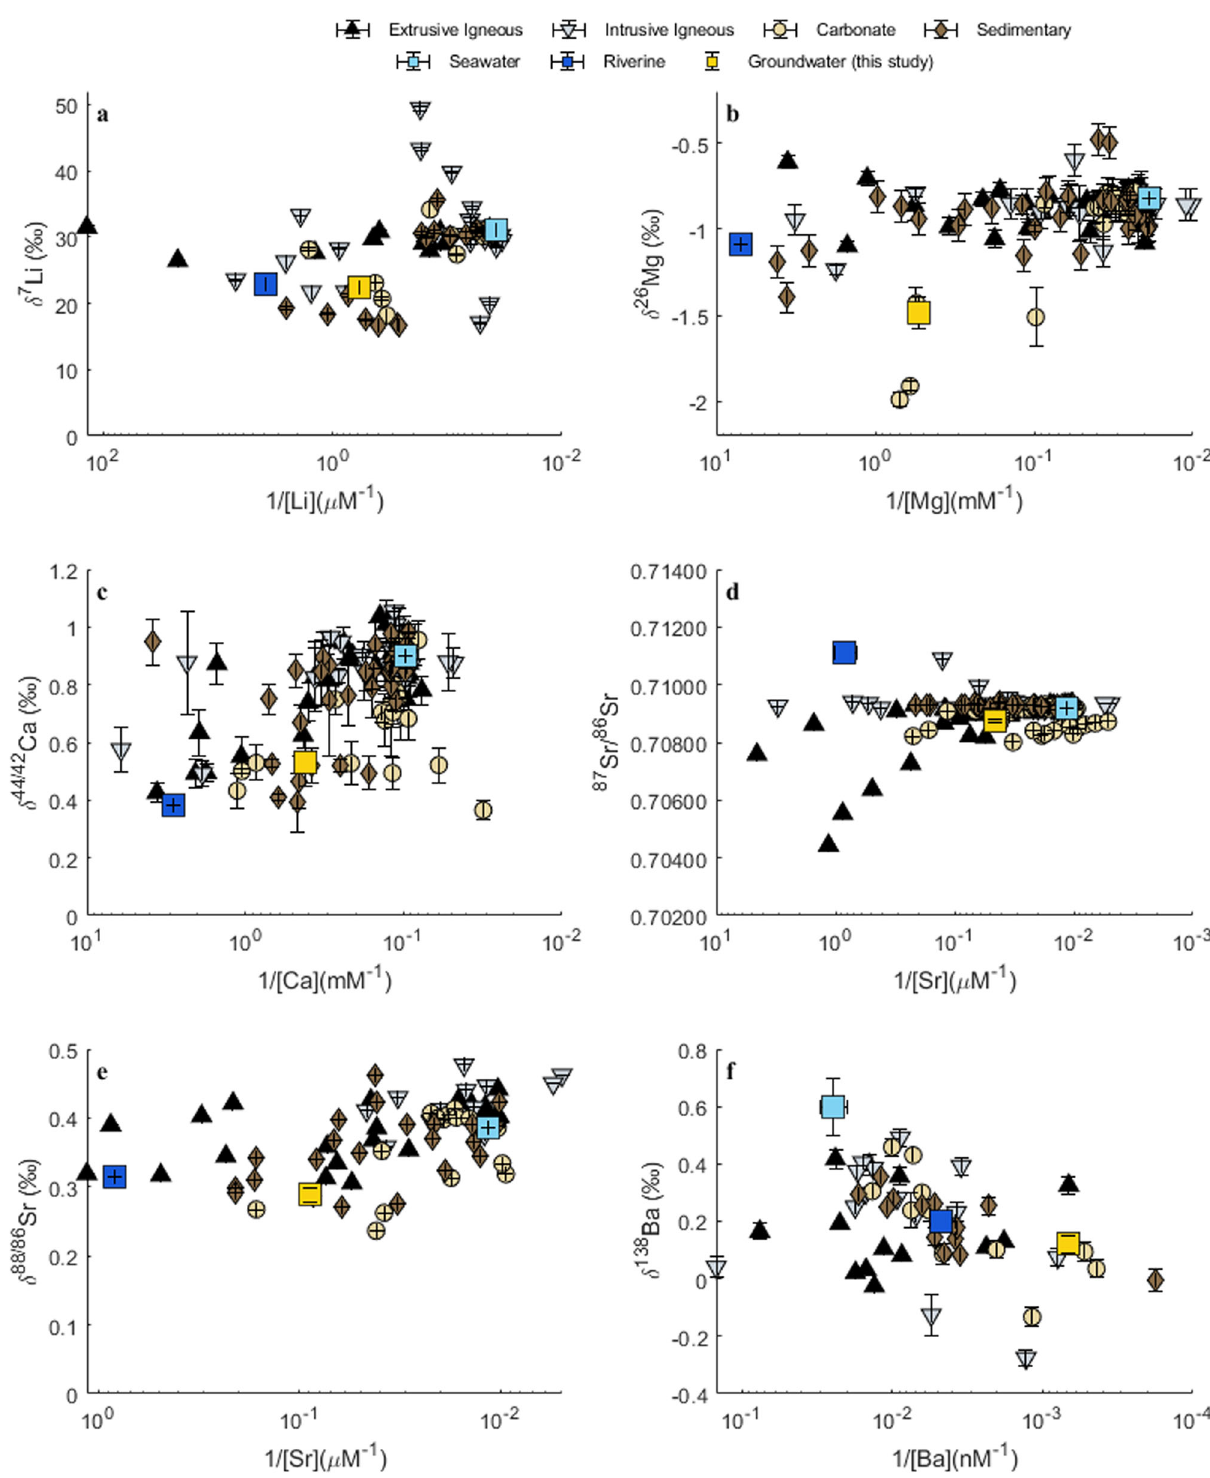
Fig. 3 Isotopic composition of samples. a – e Isotopic compositions with respect to the inverse of cation concentrations, organized by lithologic aquifer type, plotted alongside relevant endmember values: seawater and global average riverine endmembers (references available in Table 1), as well as the average global groundwater composition calculated in this study. Error bars represent the greater of 2 standard deviations (2 SD) for each sample ’ s analysis or the long-term uncertainty (2 SD) of relevant standard reference materials discussed in the supplementary information. Sample size ( n ) values are provided here: a δ 7 Li ( n = 67), b δ 26 Mg ( n = 105), c δ 44/42 Ca ( n = 114), d 87 Sr/ 86 Sr ( n = 168), e δ 88/86 Sr ( n = 79). f δ 138 Ba ( n = 56).